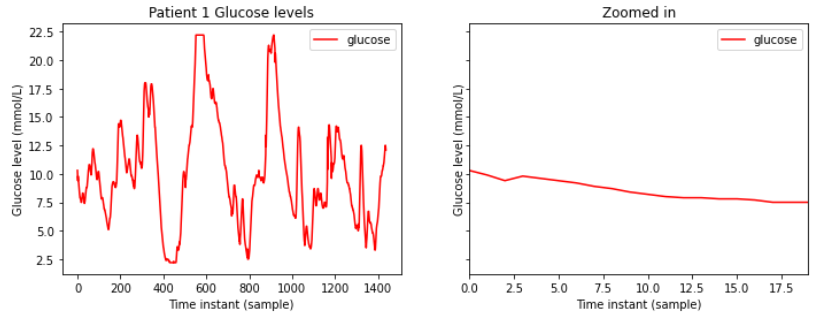
Figure 1. Patient 1 glucose blood